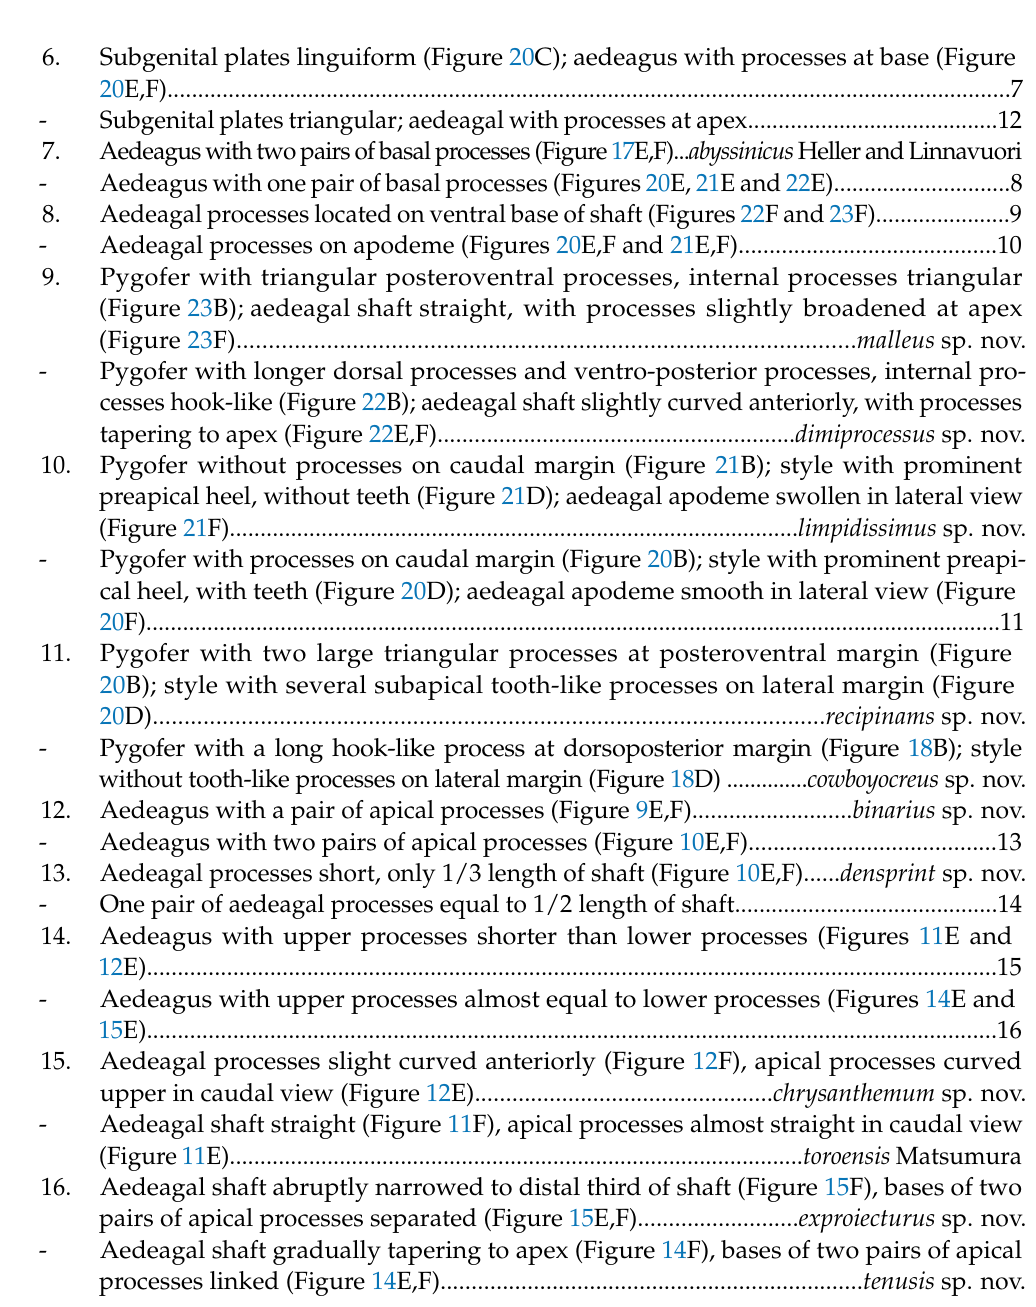
Figure 1A–F, Figure 2A–F, Figure 24A, and Figure 25A1–A3. Xestocephalus asper Linnavuori, 1969: 1149, Figure 16a–c [64]; Linnavuori, 1979: 934, Figure 49a–c [24]. Morph 1 is dark brown with grayish-white markings (Figure 1D–F): Morph 2 is pale ochraceous with gray markings (Figure 1A–C). Vertex with three round grayish-white spots on anterior margin and four grayish-white spots on submargin, discal area with a grayish-white longitudinal line on each side of brown midline and narrower transverse grayish-white band posteriorly, a small grayish-white spot adjacent to basal angles of eyes. Face pale brown, with marginal arcuate band dark brown. Pronotum dark-brown, with several distinct cream spots at anterior margin and submargin. Scutellum